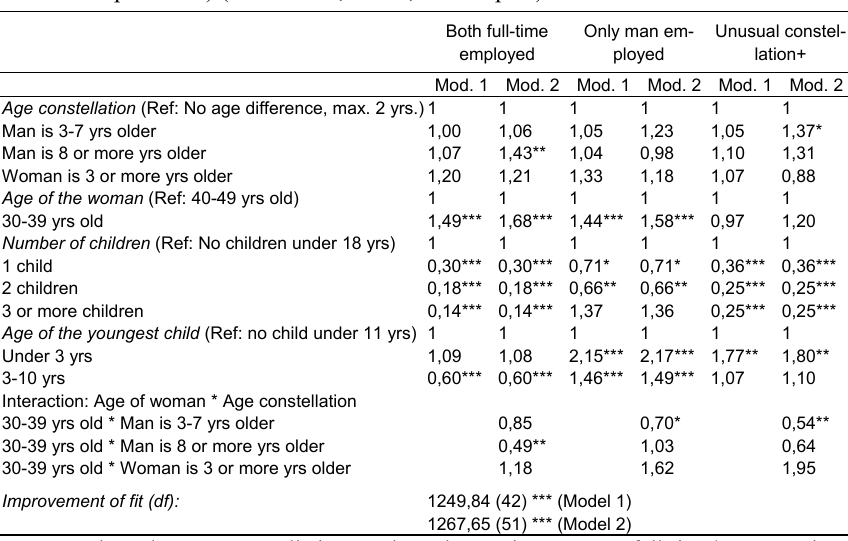
Multinomial logistic regressions on the employment constellation in academic couples (reference category: Man full-time – Woman part-time) (odds ratios, N = 4,308 couples)